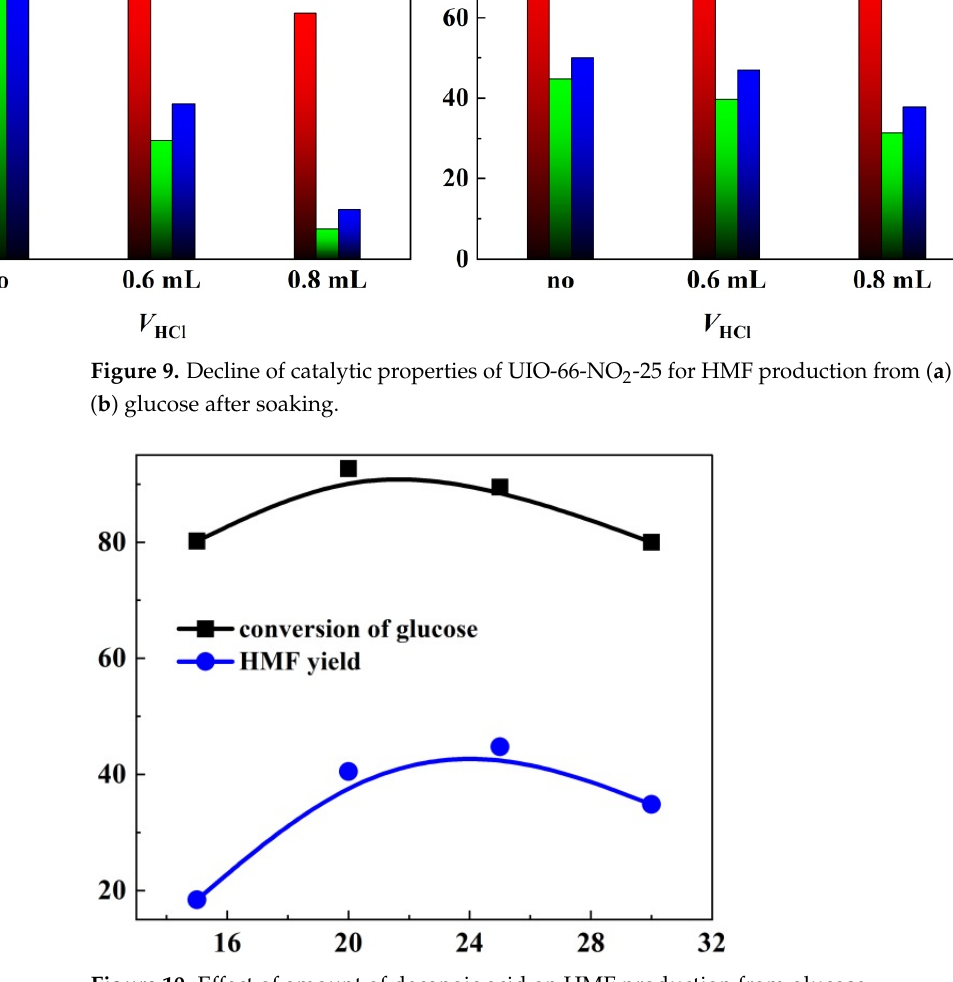
Figure 9. Decline of catalytic properties of UIO-66-NO 2 -25 for HMF production from ( a ) fructoseand ( b ) glucose after soaking.